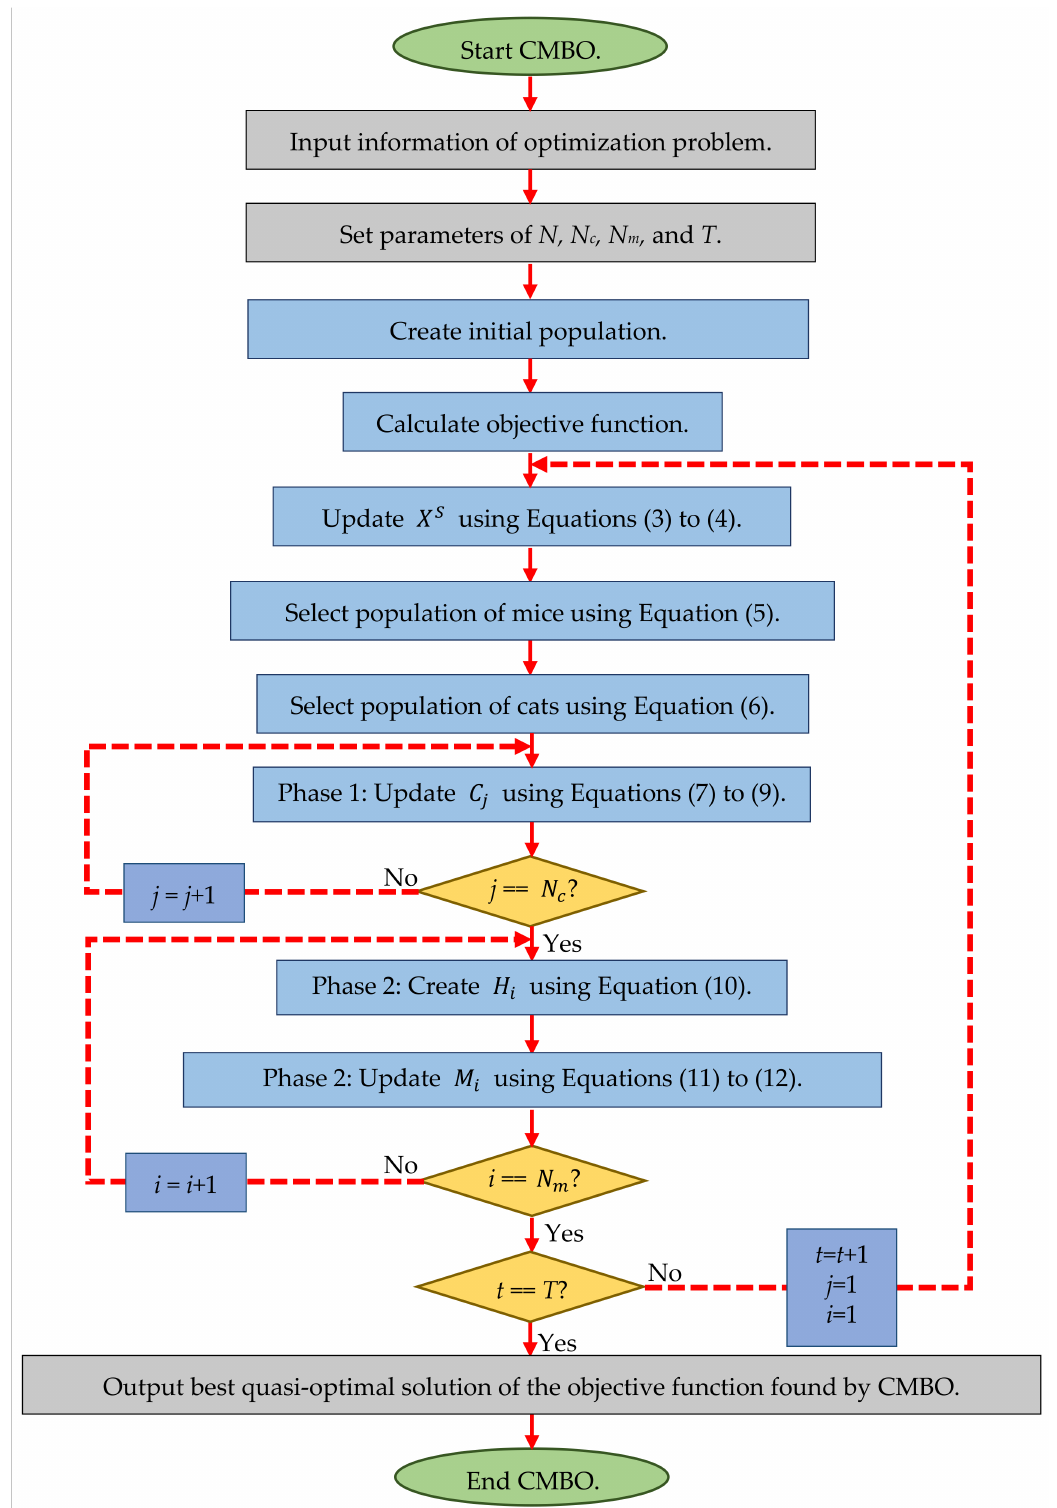
Figure 1. Flowchart of